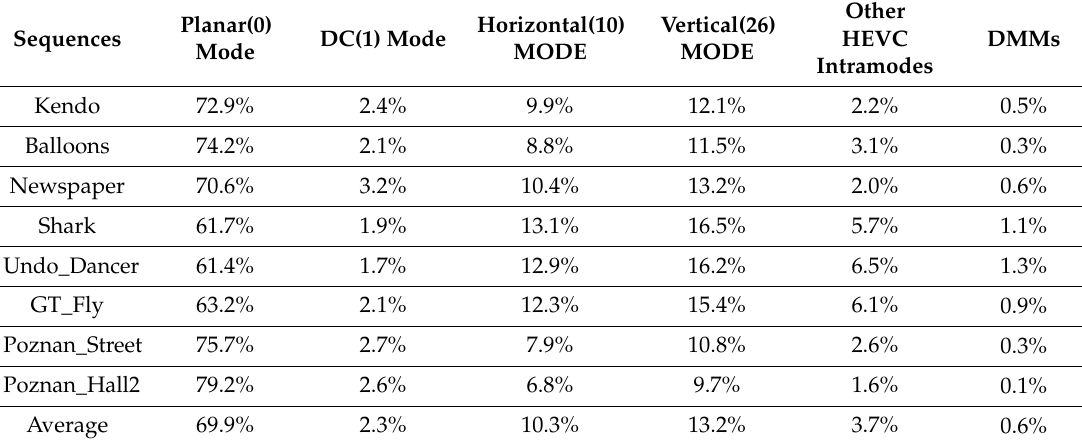
Table 5. Intramode distributions for normal region of treeblocks in depth